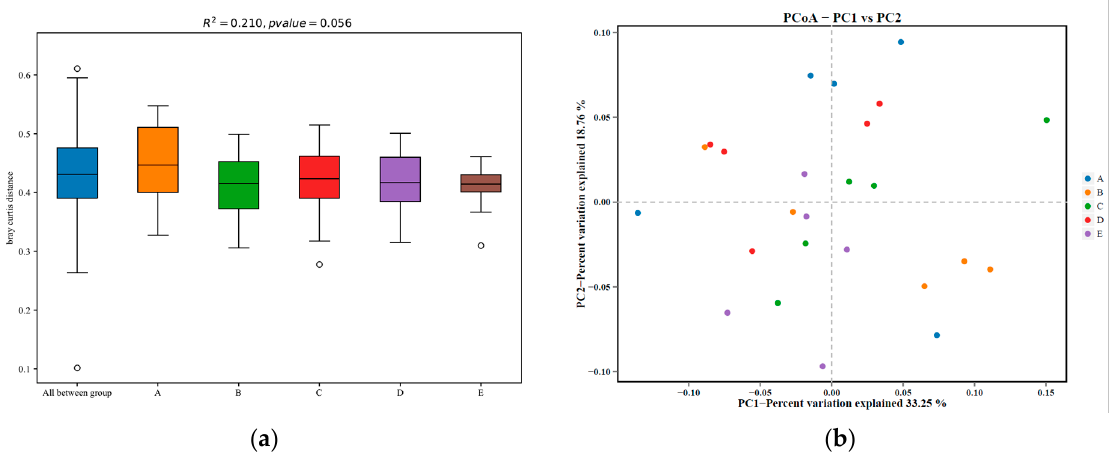
Figure 2. The analysis of similarities (ANOSIM) tests of gut microbiota performed between groups based on relative abundance of OTU ( a ) and principal coordinate analysis plot of the weighted Unifrac metric ( b ) of the colon communities of individual pigs after feeding control diet (A, CON), low protein diet (B, LP), LP + sodium dichloroacetate diet (C, LP + DCA), LP + sodium dichloroacetate diet (D, LP + GLUC), and LP + DCA + GLUC diet (E), respectively. n = 5.